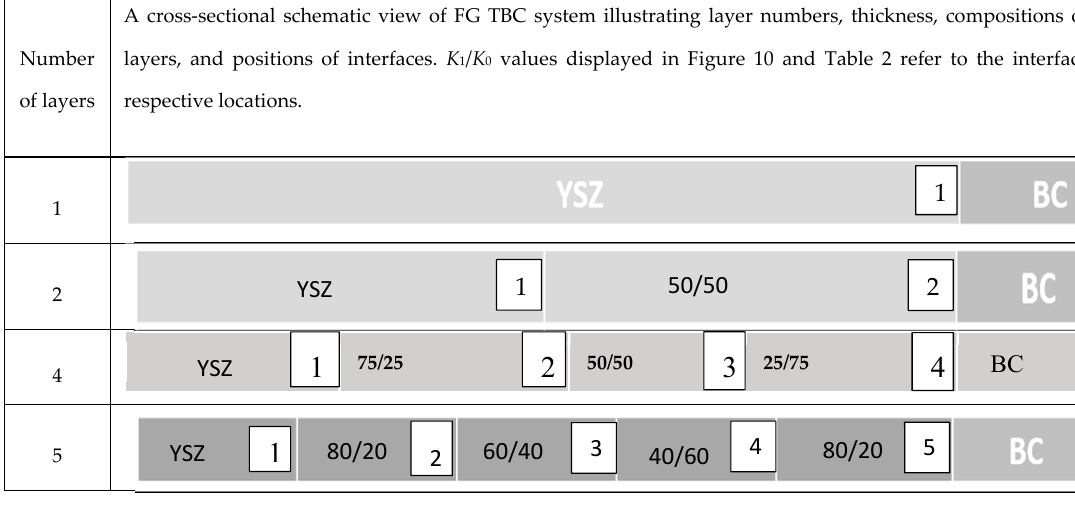
Figure 10. Designation of interfaces in three FG TBC systems (2, 4, and 5 layers) along with the base case (YSZ TC over BC). Decreasing layer thickness and the compositional changes with increase in layer numbers is also evident as the TC thickness is kept constant at 360 μ m. The number ratios represent the volume fraction of two phases in the layer, namely YSZ/BC.